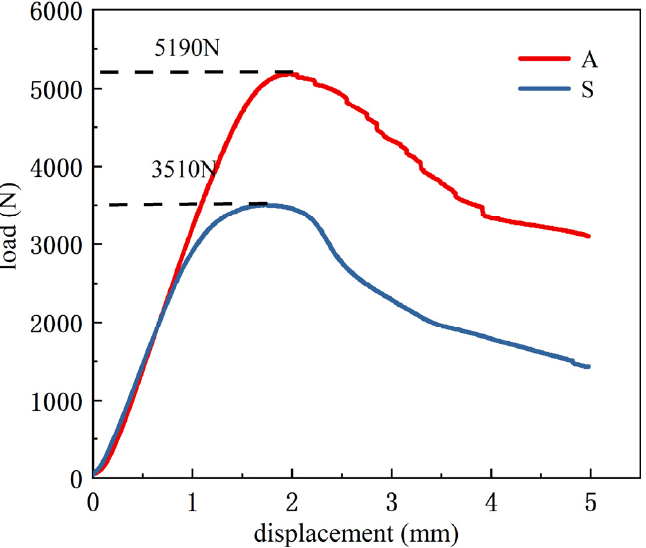
Figure 11. Compression load-displacement curve (S denotes uniform filling structure, and A denotes